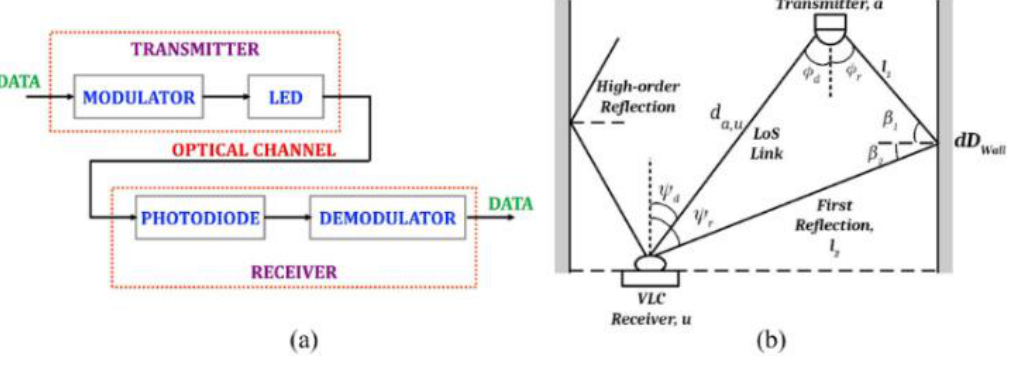
Figure 34. ( a ) Typical VLC system block diagram; and ( b ) indoor visible light propagation model.